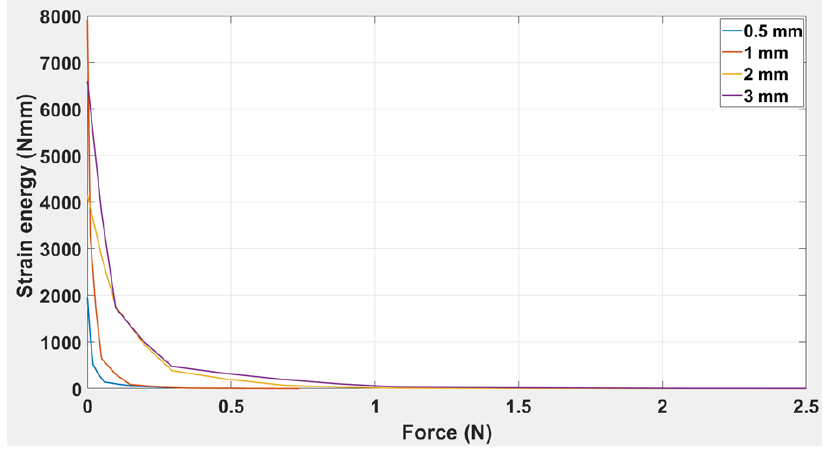
Figure 12. Strain energy vs. applied force for simple ABS beam of thickness: 0.5 mm, 1 mm, 2 mm, and 3 mm. Mathematically, Table 6. Different values of coefficients at simple ABS beams and TPU Origami capsule of different